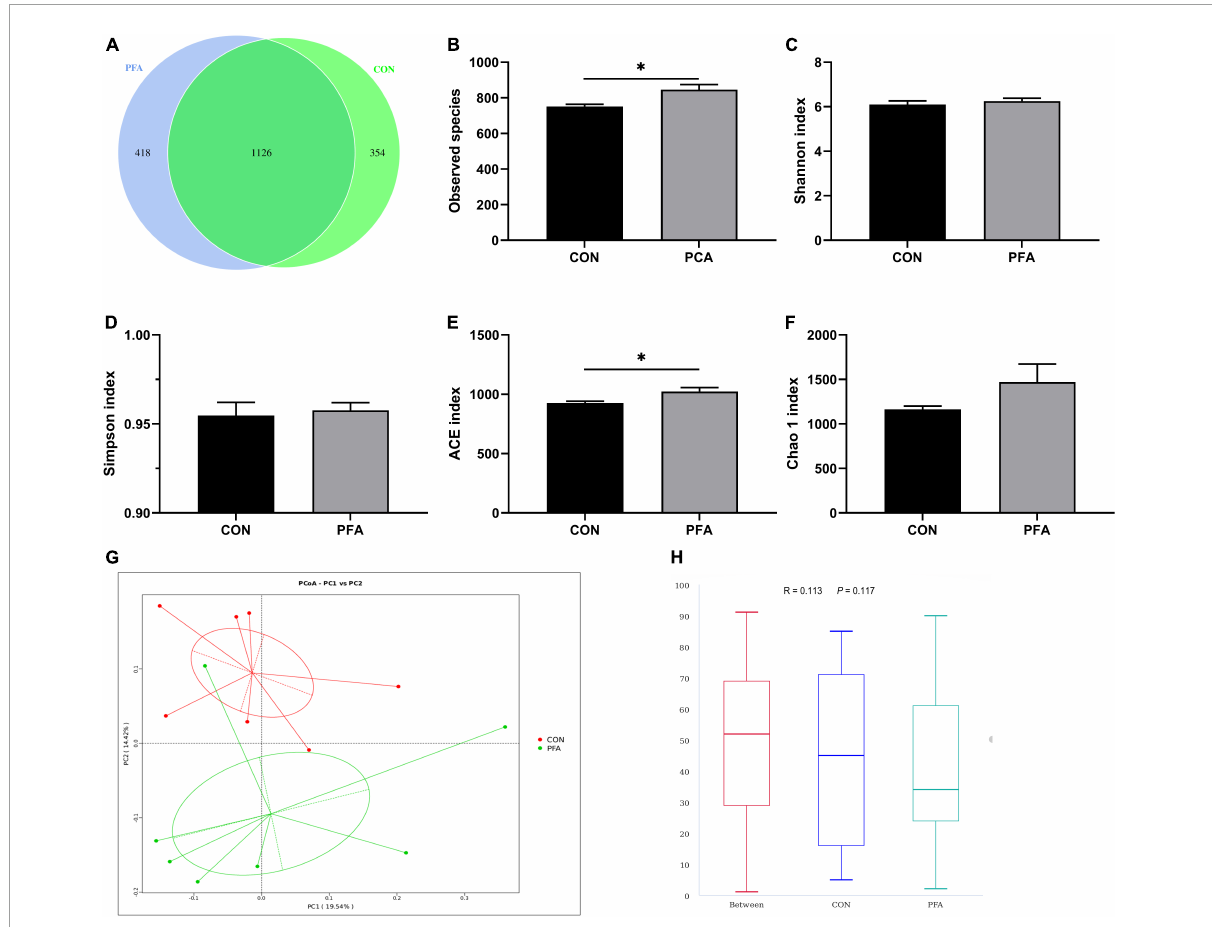
FIGURE4 Effect of dietary paraformic acid supplementation on diversity and richness of cecal microbiota in broilers. (A) A Venn diagram generated to display the common and unique operational taxonomic units between two groups; (B) Observed species; (C) Shannon index; (D) Simpson index; (E) ACE index; (F) Chao 1 index; (G) The principal coordinate analysis (PCoA) profile of bray_curtis distance; (H) Analysis of similarity. CON, broiler chickens fed basal diet; PFA, broiler chickens fed basal diet supplemented with 1,000 mg/kg paraformic acid. Values are mean ± standard error ( n = 7). Differences between treatments were displayed by ∗ P <